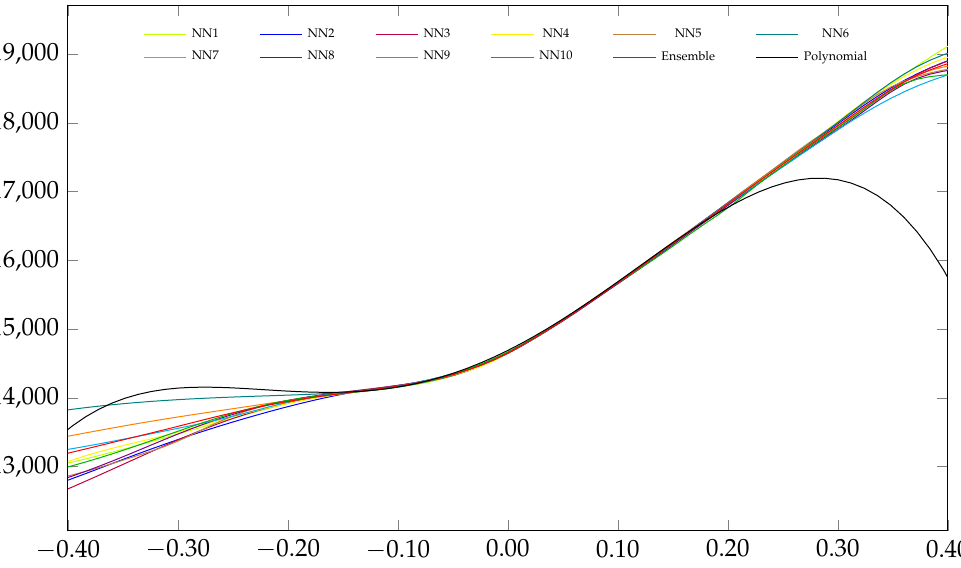
Figure A4. One-dimensional curves of the 10 best performing neural networks, their ensemble and the polynomial with respect to X 8